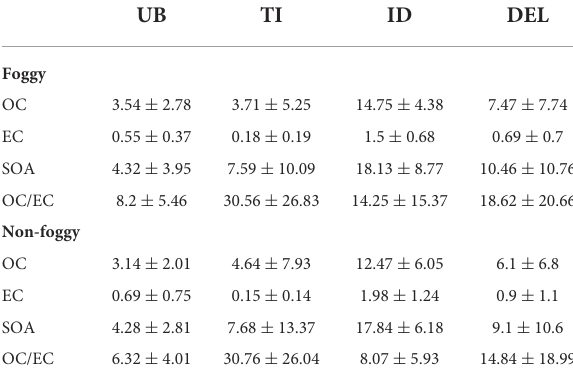
TABLE 1 Carbonaceous aerosol fractions during foggy and non-foggy days at respective sites over